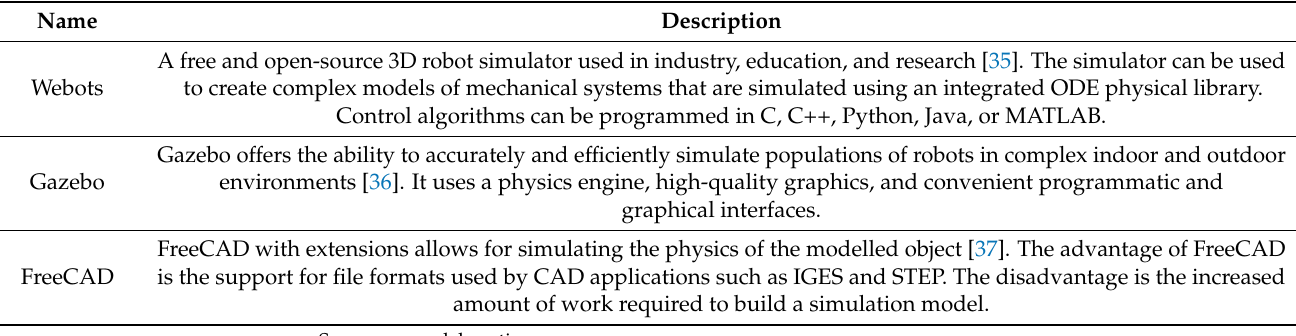
Table 5. Applications for 3D visualisation and simulation.